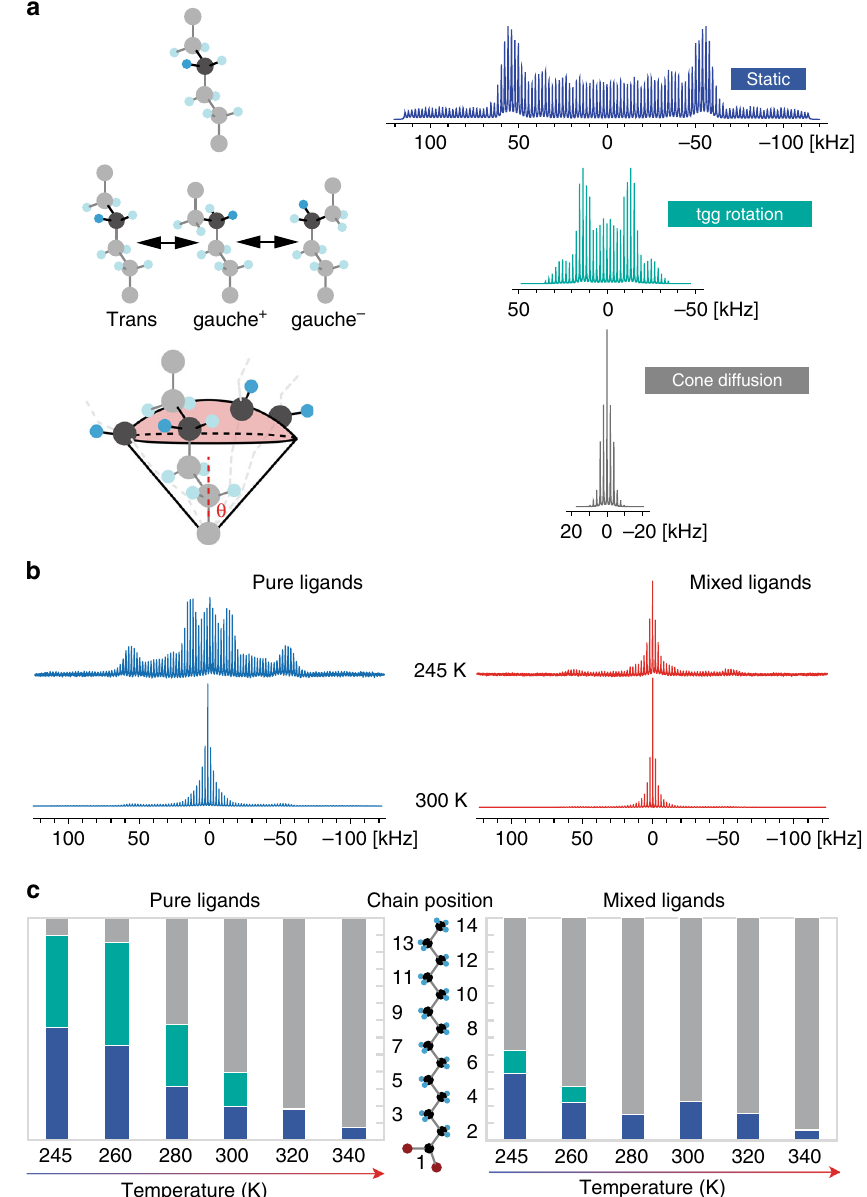
Fig. 3 2 H NMR lineshapes and chain fl exibility. a The three distinct dynamic modes of methylene units and the corresponding 2 H NMR patterns under 2 kHz magic-angle spinning. These dynamic modes could present in a hydrocarbon chain at different temperatures or at different positions, e.g., the middle segment or the free end. b 2 H NMR patterns for nanocrystal-ligands complexes with pure ligands ( f He = 0) and nanocrystal-ligands complexes with mixed ligands ( f He = 0.68) with fully deuterated myristates at 245 and 300 K. c The histograms of methylene fl exibility along the myristate ligand at variable temperatures, based on the deconvolutions of 2 H patterns. The blue, green and gray bars represent static deuterium, tgg rotation and cone diffusion, the differences in chain fl exibility between different types of nanocrystal-ligands complexes are more pronounced at the lower temperature. We deconvoluted each of the patterns in Supplementary Fig. 4 into the three dynamic modes described above with relative populations corresponding to the number of methylene units.